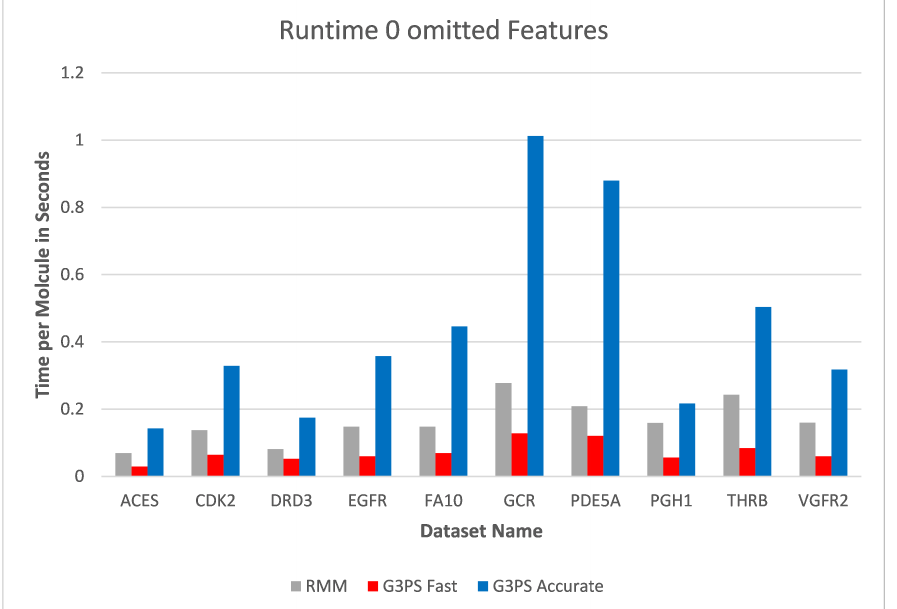
Figure 10. Screening benchmark runtimes without omitted features.